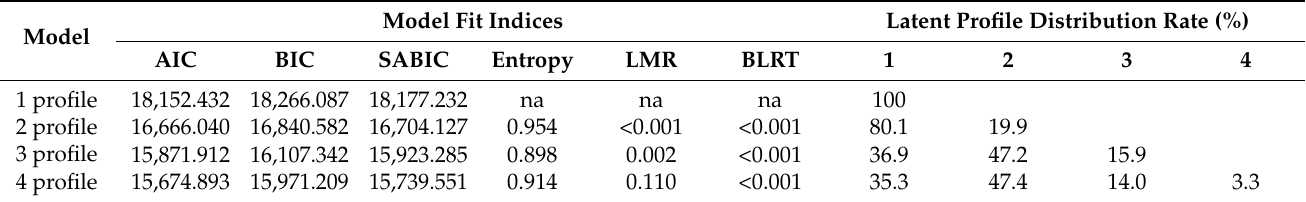
Table 2. Fit indices for models with increasing numbers of latent profiles.